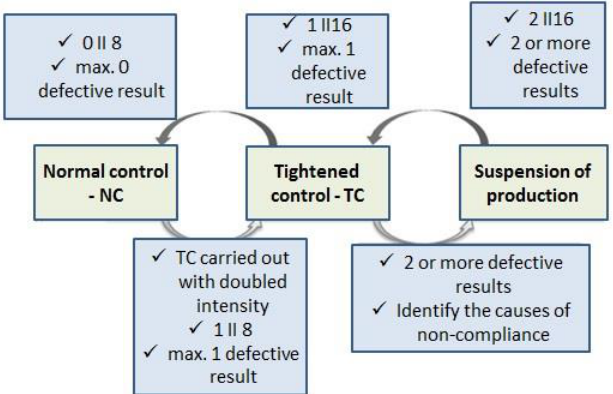
Figure 11. Conditions for the transition between the levels of control for the strength of concrete curbs (EN 1340:2004 [16]).